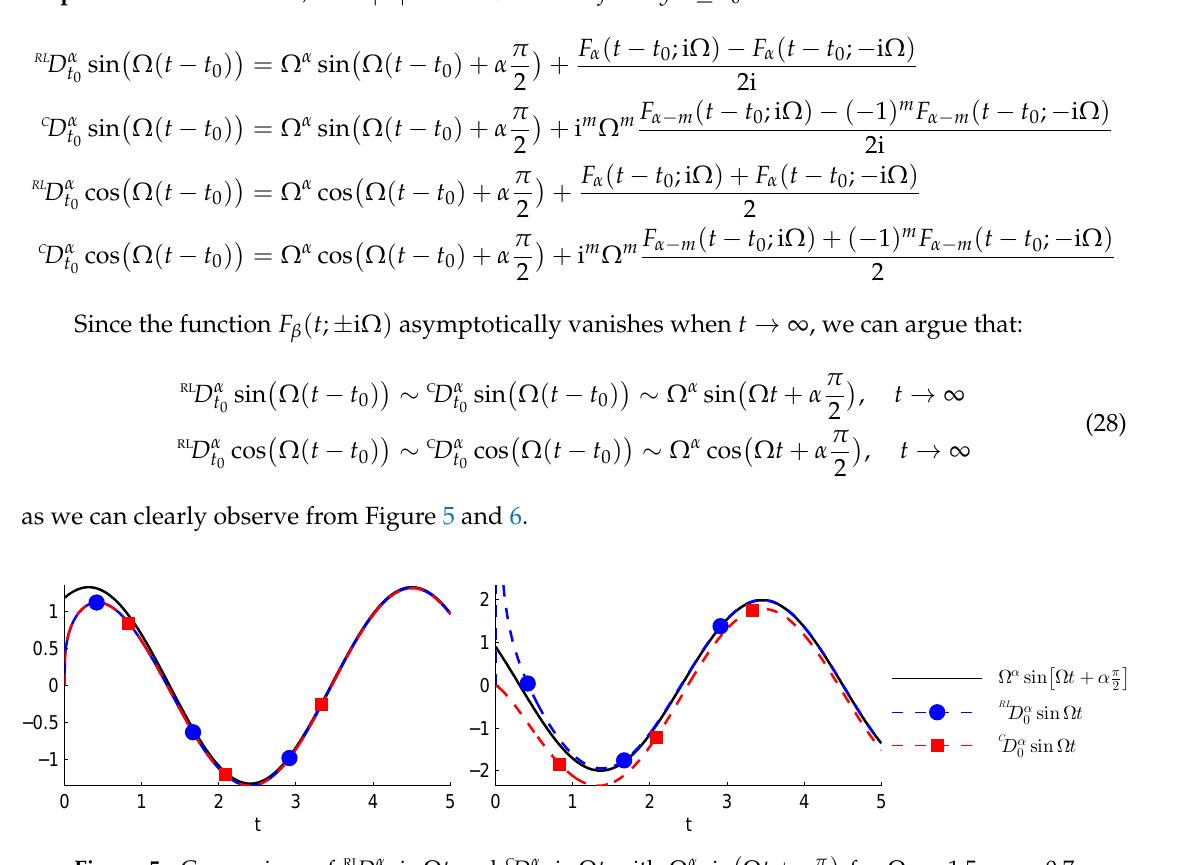
sin Ω t with Ω α sin 0